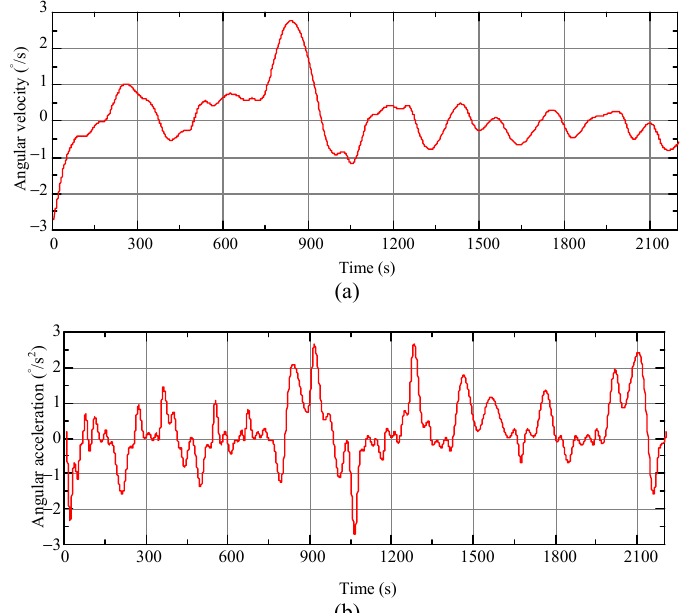
Fig. 5 Angular velocity (a) and the angular acceleration in coarse tracking (b).